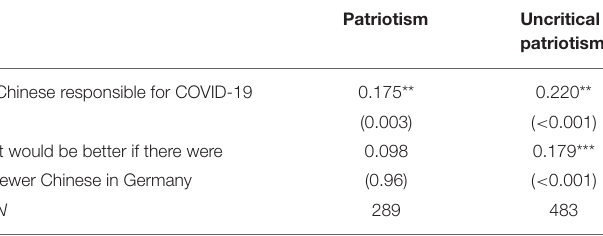
TABLE 6 | Correlations of the two variants of patriotism with Chinese responsibility and the agreement with the statement that “there are too many Chinese in